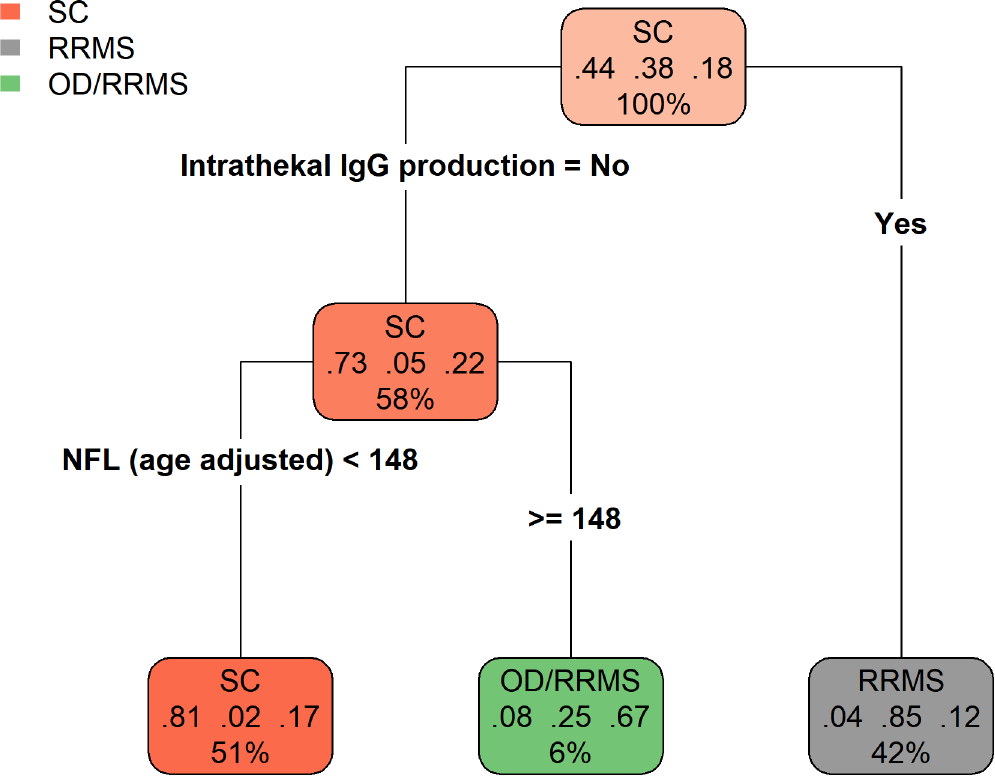
Fig 4. Classification tree model. Patients with previously undiagnosed RRMS (grey), the SC group (red), and the OD group (green) were classified by splitting the groups based on the detection of the indicated biomarkers. The class of the majority of patients in a group is shown at the top of each node. The proportions of individuals that belong to classes SC, RRMS, and OD are shown as fractions in the middle of each node. The percentage of the total number of individuals in each node is shown at the bottom of each node. This model makes two splits, the first is based on intrathecal IgG production, and the second is based on NFL levels (age-adjusted), with an optimal split in age adjusted NFL at 148 ng/L. Thus, individuals with no intrathecal IgG production and low levels of NFL were predicted to be SC (51%). Among the individuals that satisfied these two criteria, 81% were truly SC, 2% had RRMS, and 17% had some other disease. Only 6% of individuals exhibited no intrathecal IgG production and high levels of NFL. Of these, 8% were SC, 25% had RRMS, and 67% had OD. Finally, 42% of individuals exhibited only intrathecal IgG production. Of these, 4% were SC, 85% had RRMS, and 12% had OD. The calculation for age-adjusted NFL is: NFL– 203.3–15.9 (cid:3) Age (y), as estimated by linear regression of the HC